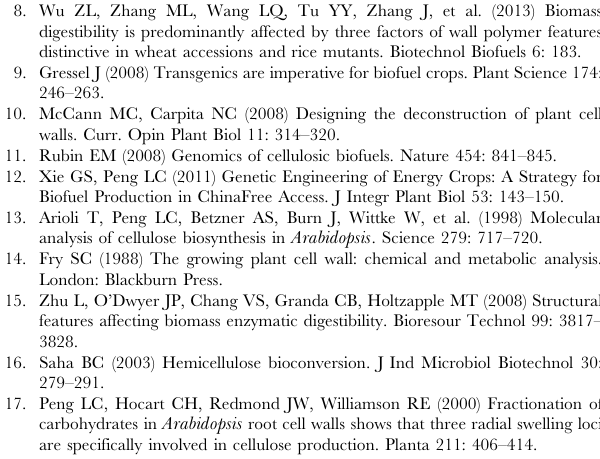
Table S5 Monomer composition of lignin. Table S6 Correlation coefficients between lignocellu- lose CrI values and hexoses yields from enzymatic hydrolysis after various chemical pretreatments in the typical corn samples. Table S7 Correlation coefficients between hemicellu- losic Xyl/Ara ratios and hexoses yields from enzymatic hydrolysis after various chemical pretreatments in the typical corn samples. Table S8 Correlation coefficients between monolignin ratios and hexoses yields from enzymatic hydrolysis after various chemical pretreatments in the typical corn